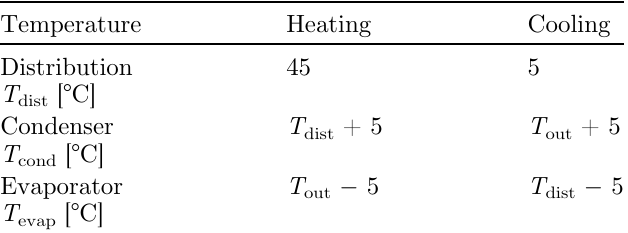
Table 1. Heat pump fl uid